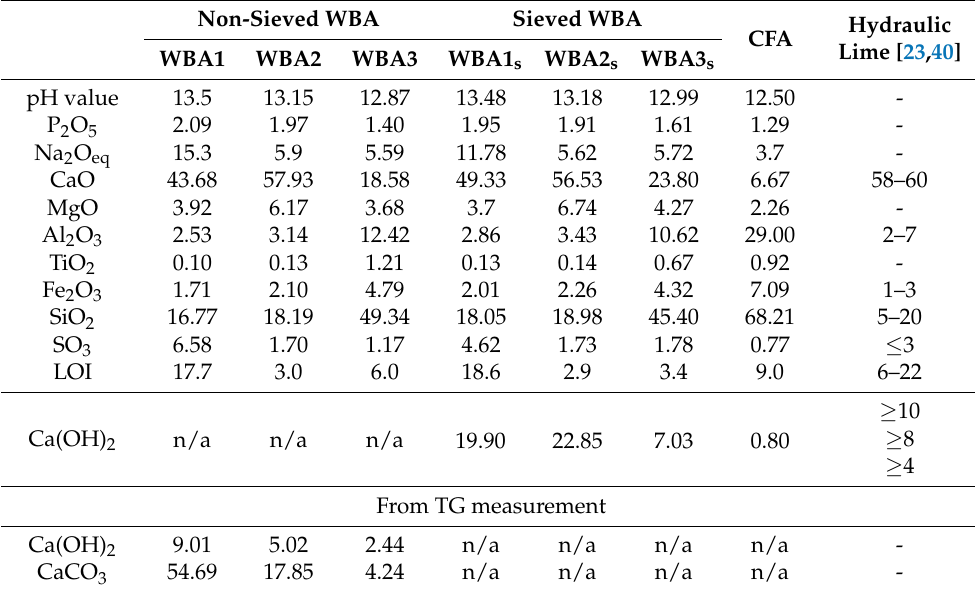
Table 5. Chemical composition of WBAs and CFA used compared to HL